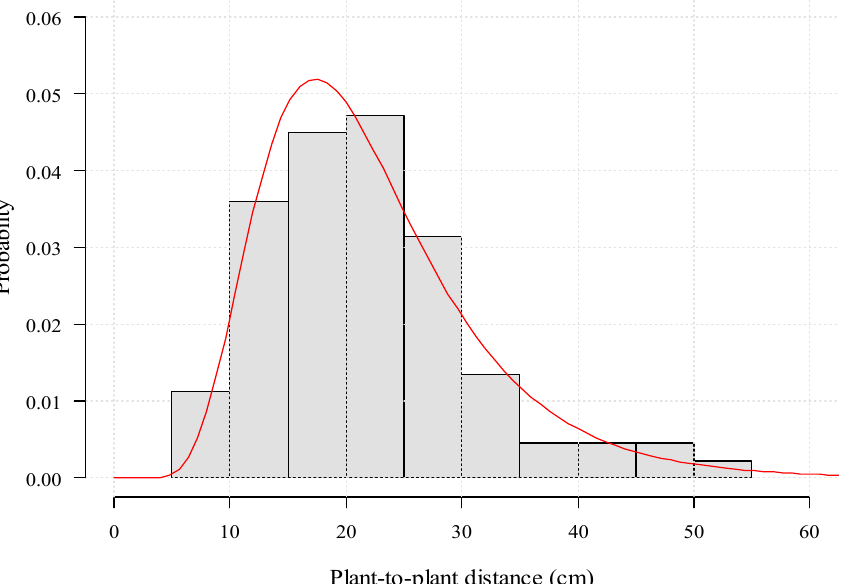
Figure 3. Distribution of the plant-to-plant distances within the study area, 2017. The red line represents the hypothetical lognormal distribution.